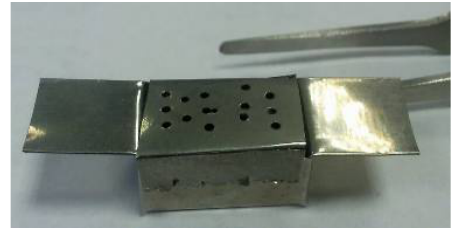
Fig. 1. CaCO 3 target after 2 h irradiation with 15 µA proton Table 3. 16 MeV proton and 25 MeV alpha ranges and stopping powers in calcium targets Fig. 2. Crucible with perforated cover used for calcium carbonate conversion in vacuum by resistant heating